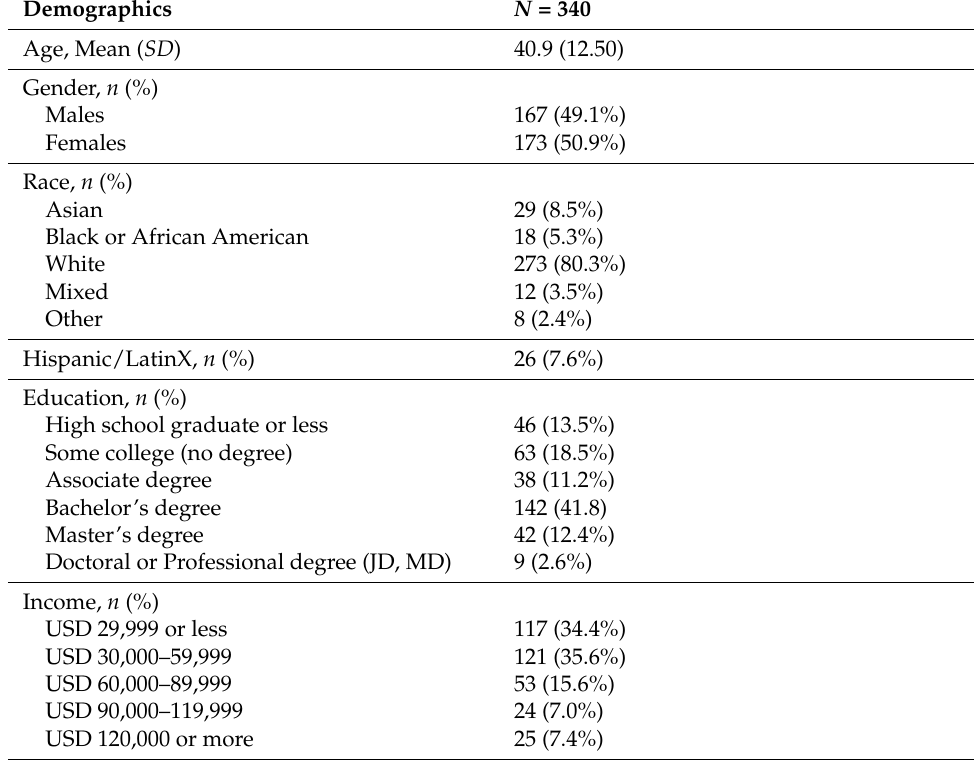
Table 1. Demographics of the analyzed